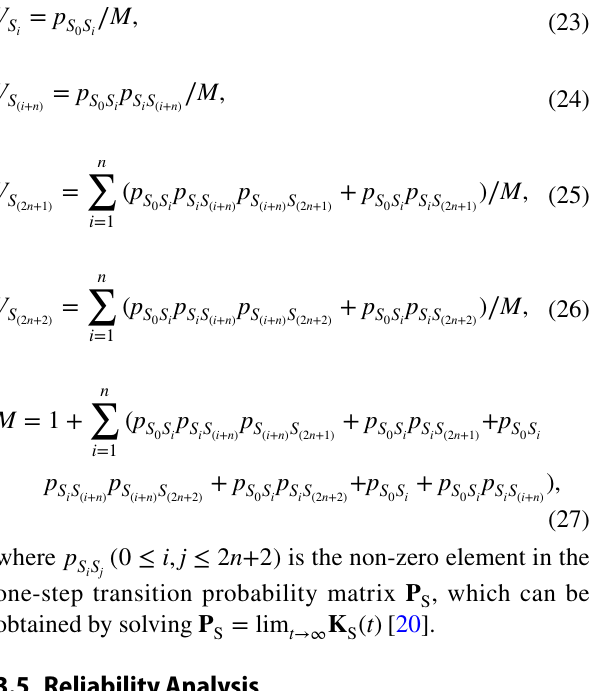
Table 3 Type of cumulative distribution function and default value used in the experiment